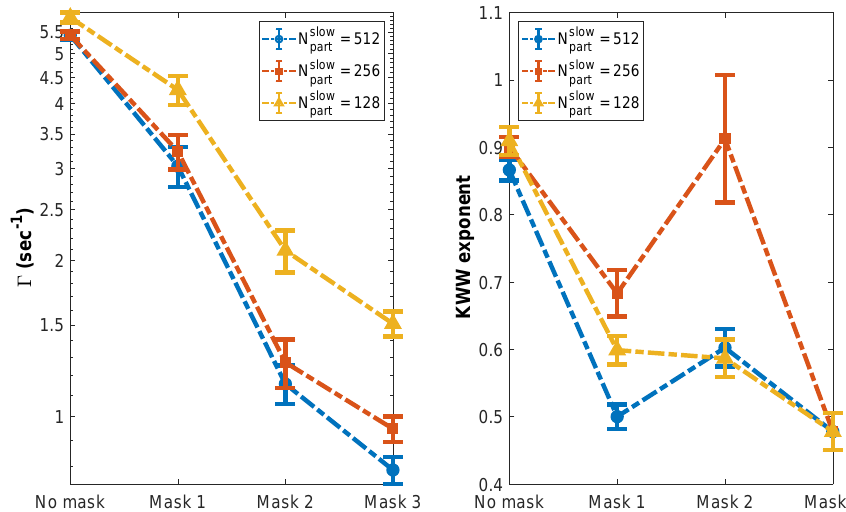
Figure 5. Decay rate ( Γ ) ( left ) and KWW exponents ( right ) for different masks and slow moving particle concentration in model 3. The values have been extracted fitting the OTCFs of Figure 4 with a KWW function (see text for